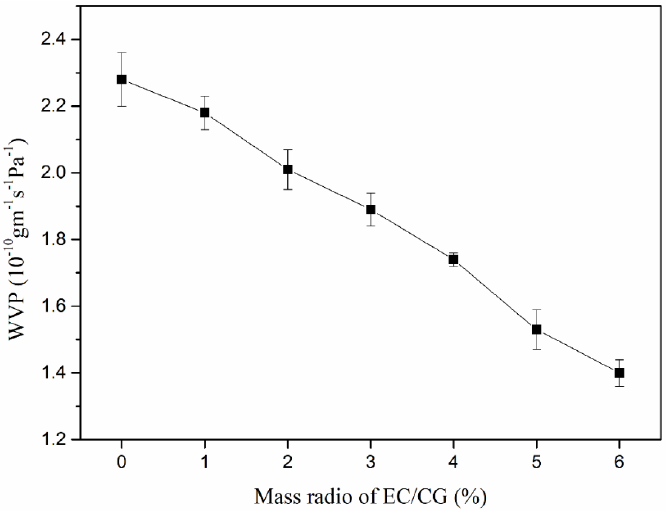
Figure 3. The relationship between WVP and the ratio of CG/EC.